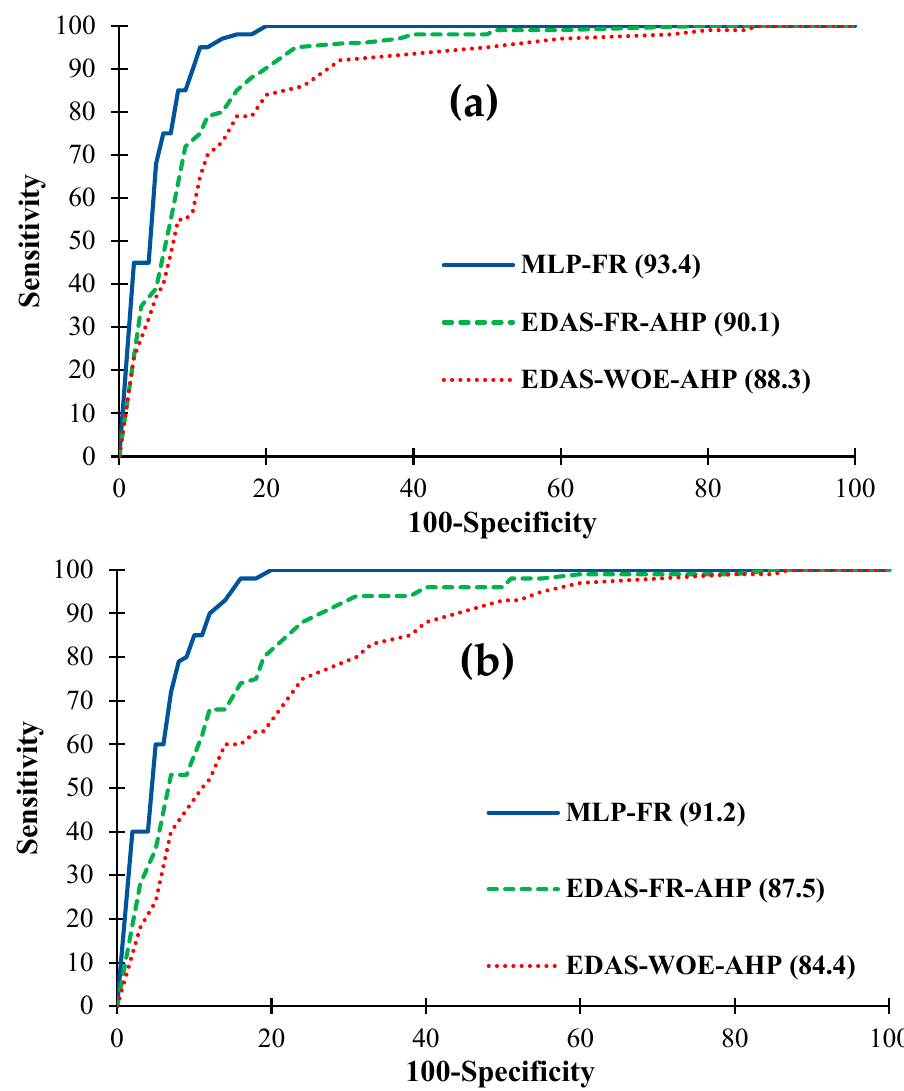
Figure 8. Model efficiency evaluation for: ( a ) success rate ( b ) prediction rate.